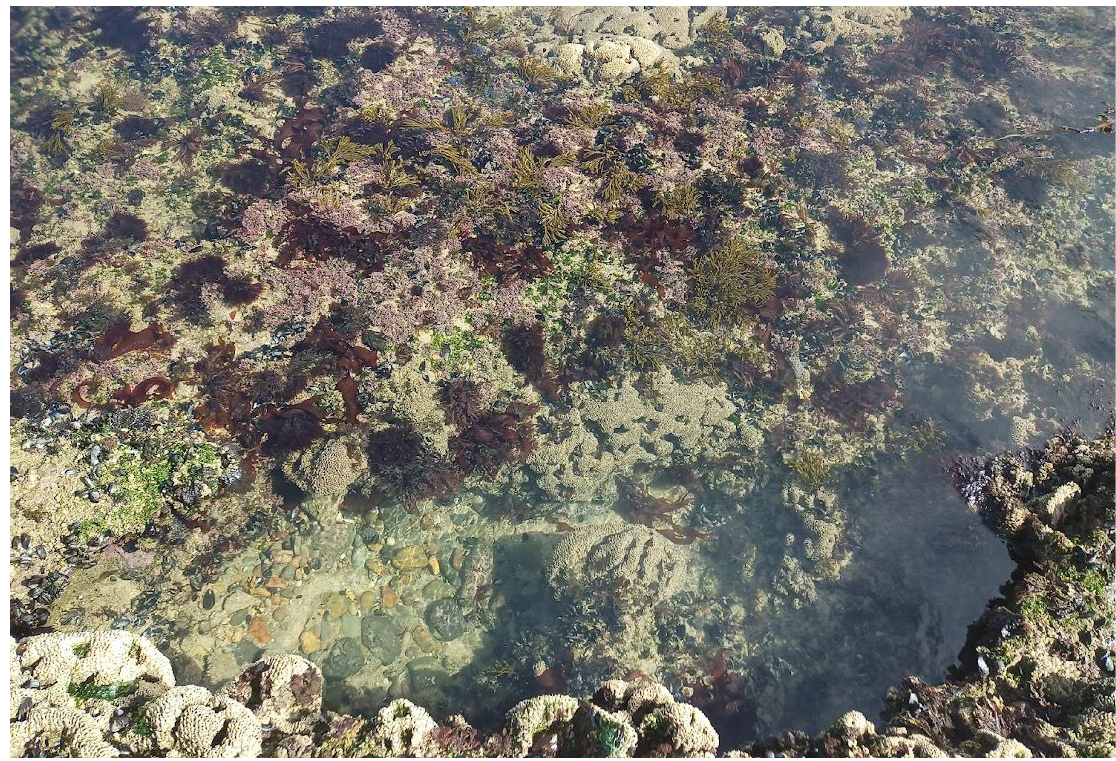
Figure 2. Ecological niche with seaweeds and other marine organisms.